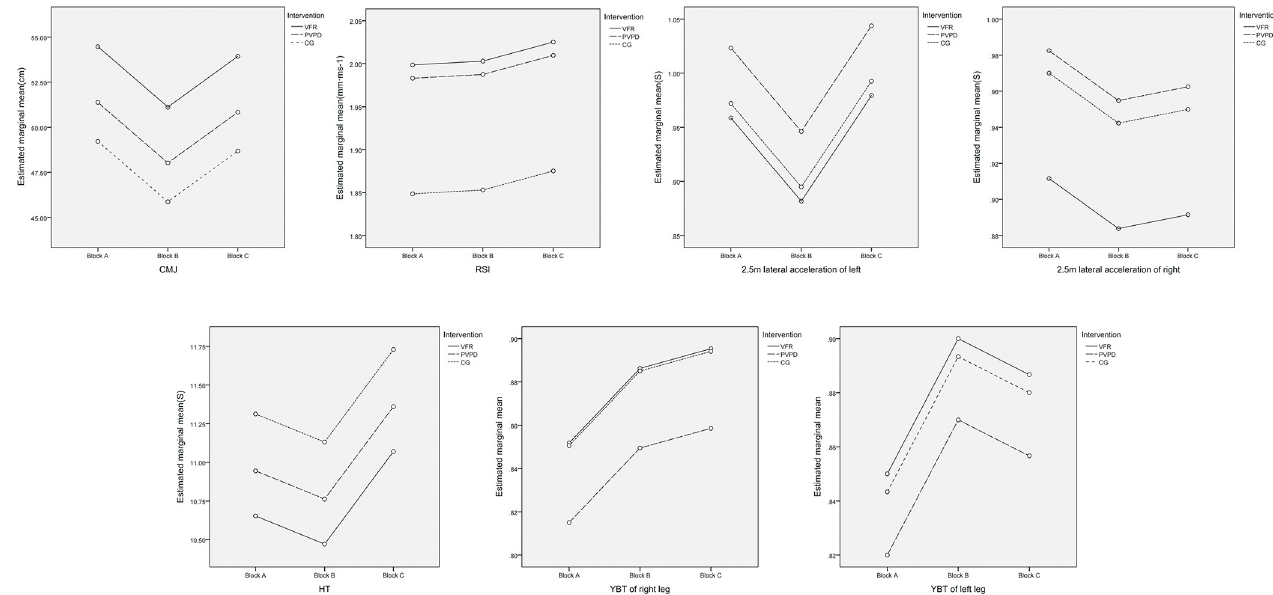
Fig 5. The estimated marginal mean profile